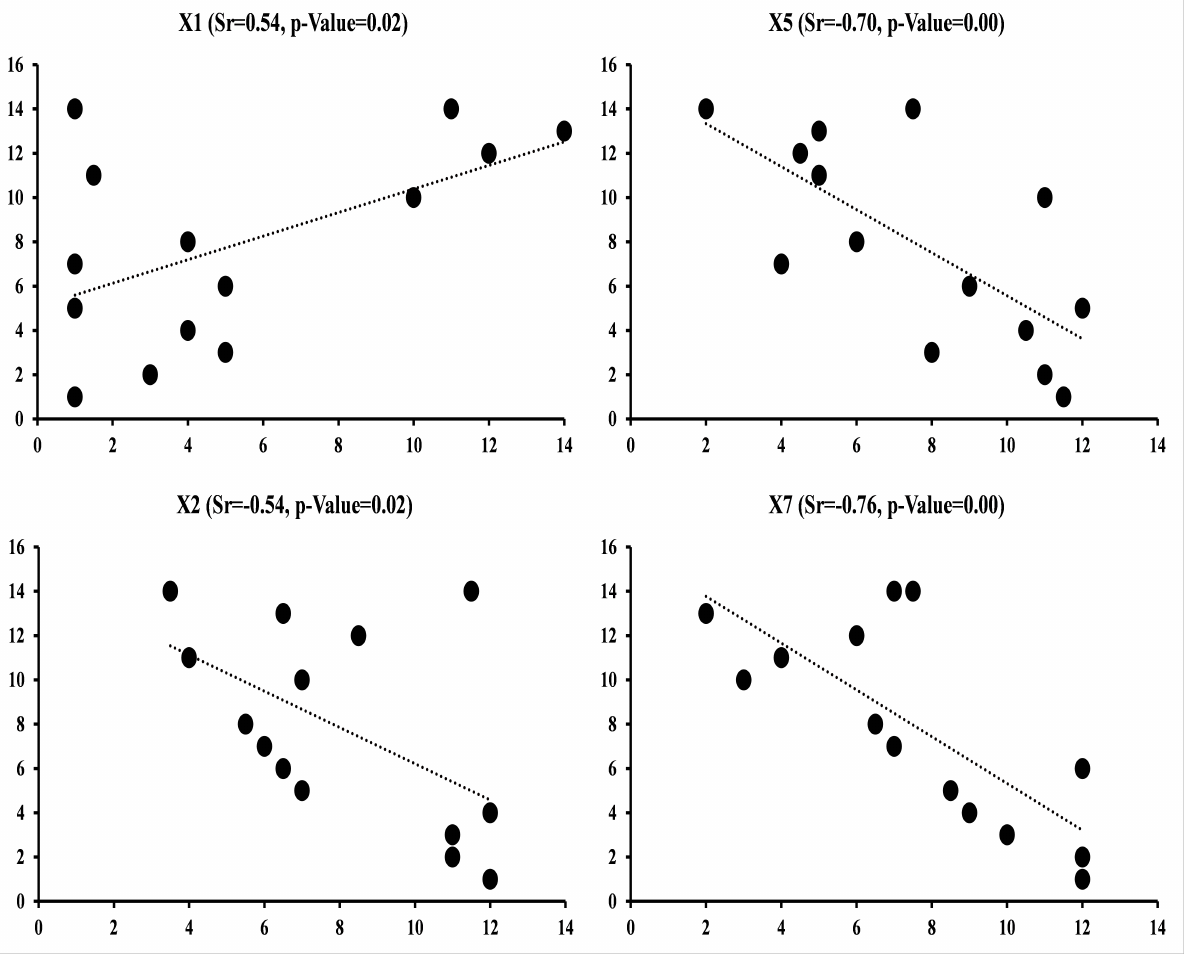
Fig. 4. Spearman rank correlation models of the strong (X5 and X7) and moderate (X1 and X2) input